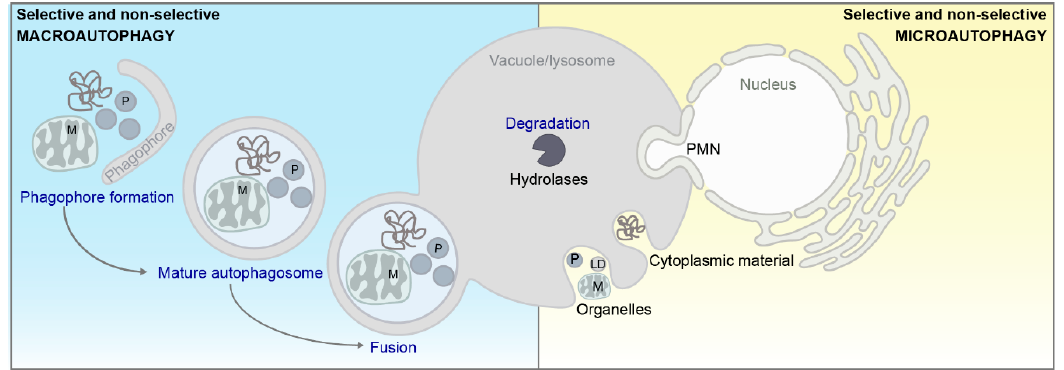
Figure 1. Schematic overview of macro or bulk- (blue)- and microautophagy (yellow). For a general description of autophagy, please see main text. PMN = piecemeal microautophagy of the nucleus, P = peroxisome, M = mitochondria, LD = lipid droplet.